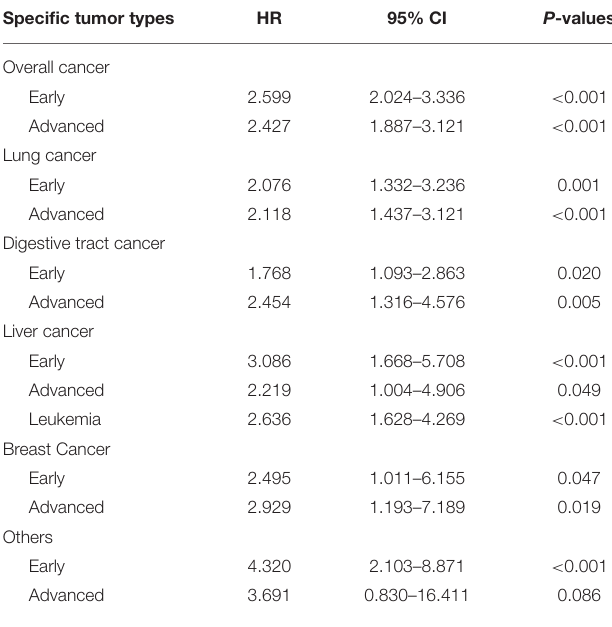
TABLE 4 | Hazard risk for all cancers mortality in patients with diabetes stratified by stages. Specific tumor